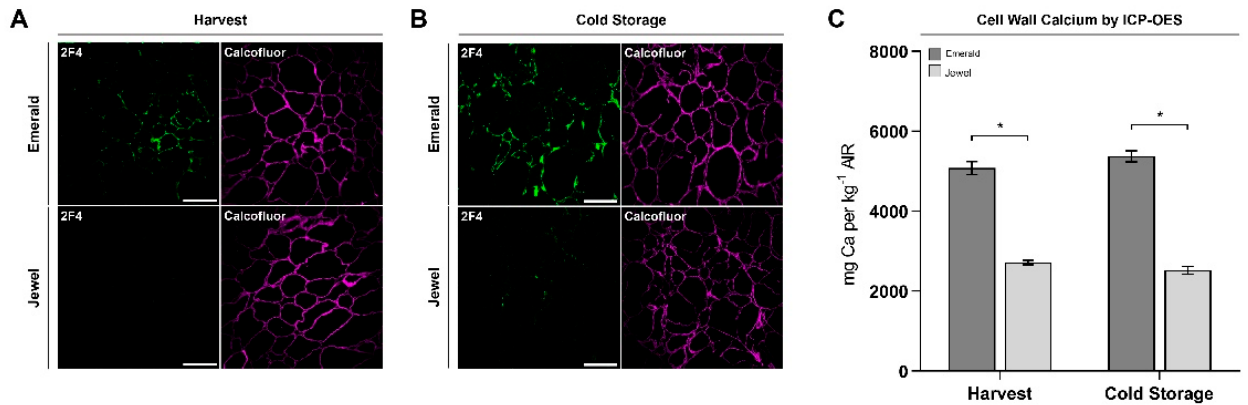
Figure 5. Immunolabeling of blueberry tissues from “Emerald” and “Jewel” cultivars at harvest and after 30 d of cold storage. Homogalacturonan/calcium dimer detection (green) at harvest ( A ) and after cold storage ( B ). Counterstaining of cellulose (magenta). Bars = 100 µ m (n = 3). Cell wall calcium quantification of the Emerald and Jewel cultivars at harvest and after 30 d of cold storage ( C ). Error bars represent SEM (n = 5). Data were analyzed by t -test (* p < 0.05).